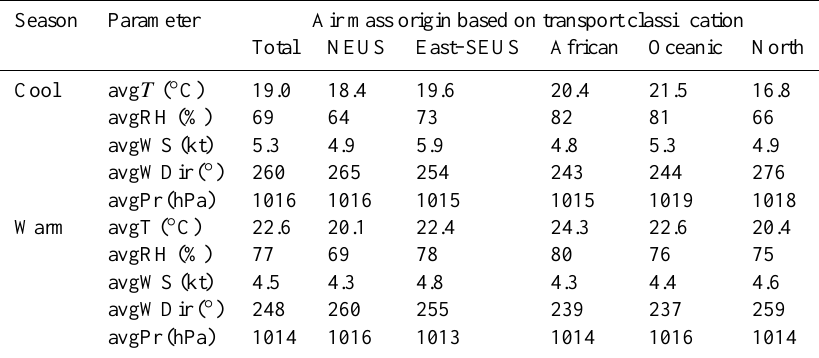
Fig. 2. Transport regime frequencies based on all days during the 3yr duration of the project for (a) the cool season, October through March and (b) the warm season, April through September. Corresponding transport frequencies based on the subset of all days for which nss SO 2 − data were available during the (c) cool season and (d) warm season. Table 3. Meteorological conditions recorded during sectored (sampling) flow periods. Seasonal average conditions and the average conditions associated with each FLEXPART defined flow